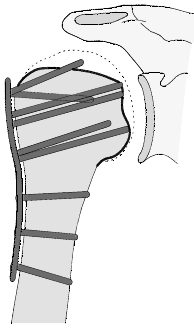
Figure 19. Complication Type 4a. Sample image. Humeral head necrosis after angle-stable plate osteosynthesis is depicted by the transition of the dashed drawing (regular humeral head anatomy) to the inhomogeneous, prominent black drawing. A cutout of the most cranial screw results, but this does not cause damage to the glenoid articular surface.